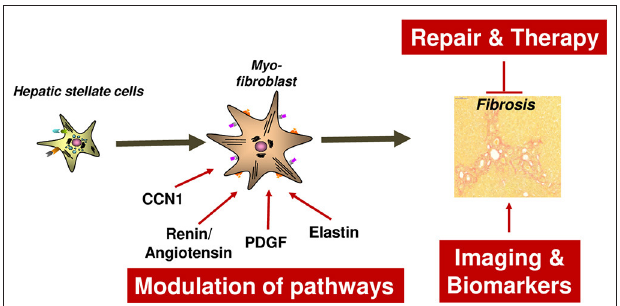
FIGURE 9 | Concepts for the repair and modulation of liver fibrosis. Detailed explanations are given in the main text. CCN1, Cellular Communication network factor 1; PDGF, Platelet-derived growth